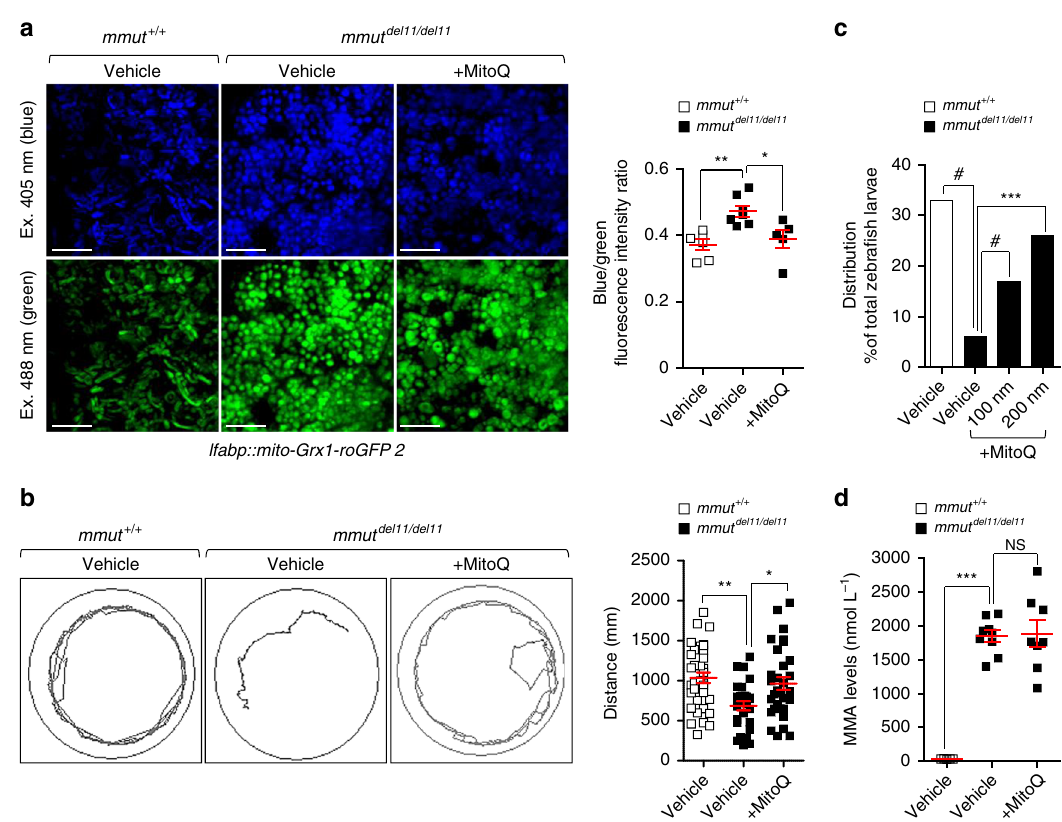
Fig. 9 Mitochondria-targeted ROS scavenger MitoQ rescues the MMA – associated phenotypes in mmut – de fi cient zebra fi sh. a – d Zebra fi sh larvae were treated with vehicle or with the mitochondria-targeted ROS scavenger MitoQ (100 nM or 200 nM, respectively, for 24 h). a Representative images and quanti fi cation of ratio between 405 (blue) and 488 (green) fl uorescence intensities in mmut zebra fi sh expressing mito-Grx1-roGFP2 in the liver. Each point represents the average fl uorescence intensity ratio in an individual zebra fi sh liver; n = 6 vehicle-treated mmut + / + zebra fi sh and n = 7 vehicle- treated mmut del11/del11 zebra fi sh, and n = 5 MitoQ-treated mmut del11/del11 zebra fi sh larvae. Kruskal ‒ Wallis followed by Dunn ’ s multiple comparison test, * P < 0.05 and ** P < 0.01 relative to vehicle-treated mmut + / + or vehicle-treated mmut del11/del11 zebra fi sh larvae. b Tracking analyses of motor behaviour in 10-dpf- mmut zebra fi sh larvae. Quanti fi cation of distance, with each point representing the average distance covered by an individual zebra fi sh; n = 28 vehicle-treated mmut + / + , n = 27 vehicle-treated mmut del11/del11 and n = 31 MitoQ-treated mmut del11/del11 zebra fi sh larvae. One-way ANOVA followed by Bonferroni ’ s post hoc test, * P < 0.05 and ** P < 0.01 relative to vehicle-treated mmut + / + or to vehicle-treated mmut del11/del11 zebra fi sh larvae. c Distribution of mmut zebra fi sh larvae (expressed as the percentage of total larvae) after treatment with either vehicle or MitoQ. Values are from one biological repeat, with n ≥ 77 mmut zebra fi sh larvae per each group/condition. Chi-square goodness of fi t test, *** P < 0.001 and # P < 0.0001 relative to vehicle-treated mmut + / + or mmut del11/del11 zebra fi sh larvae. d Quanti fi cation of MMA levels by LC-MS/MS; n = 5 vehicle-treated mmut + / + , n = 9 vehicle-treated mmut del11/del11 and n = 8 MitoQ-treated mmut del11/del11 zebra fi sh larvae. Plots represent mean ± SEM. Kruskal – Wallis followed by Dunn ’ s multiple comparison test, ** P < 0.01 relative to vehicle-treated mmut + / + or vehicle-treated mmut del11/del11 zebra fi sh larvae. Scale bars, 100 μ m. NS non- signi fi cant. Source data are provided as a Source Data fi